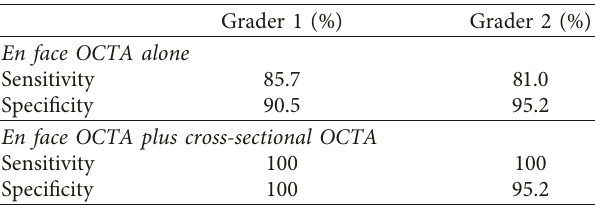
Table 2: Sensitivity and specificity of two masked graders in the detection of retinal NV on OCTA relative to